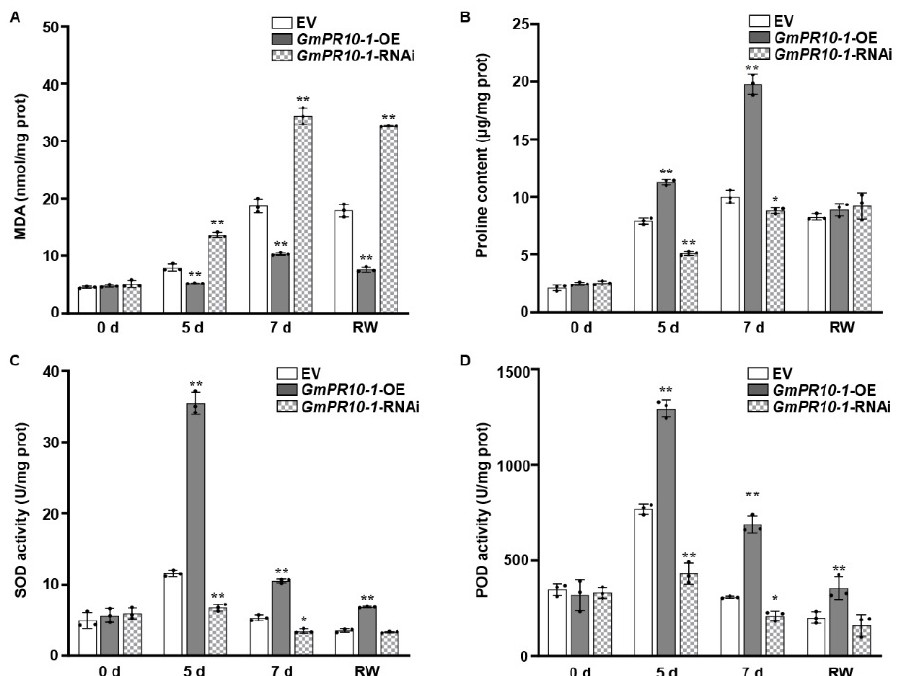
Figure 6. Overexpression or silencing of GmPR10-1 alters the drought-related parameters in composite soybean plants. ( A–D ) Malondialdehyde content (MDA; A ), proline content ( B ), and superoxide dismutase (SOD; C ) and peroxidase (POD; D ) activities of EV, GmPR10-1- OE, and GmPR10-1- RNAi composite soybean plants with transgenic hairy roots that were exposed to drought stress for 0, 5, and 7 days and re-watered for 2 days. The second trifoliate from the top was chosen to measure physiological indicators. These experiments were performed on three biological replicates, each with three technical replicates, and were statistically analyzed using Student’s t -test (* P < 0.05, ** P < 0.01). The bars indicate the standard deviation of the mean.